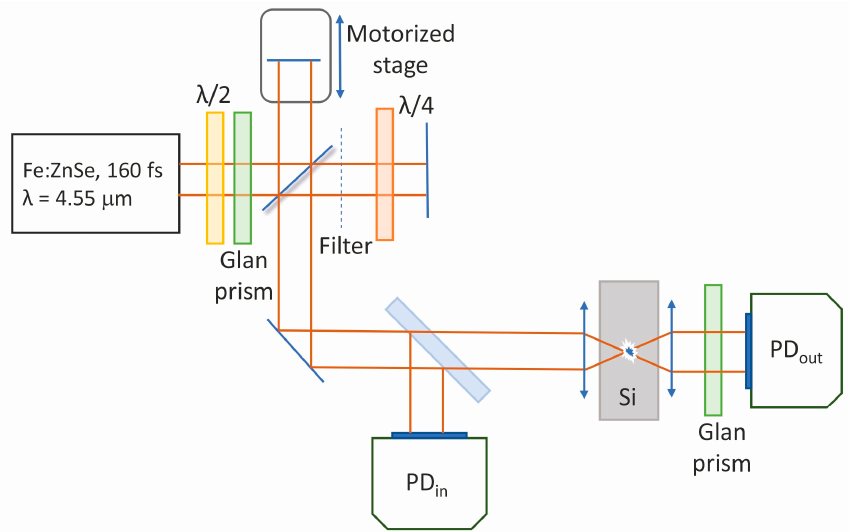
Figure 1. Experimental setup. The energy of the laser pulse is controlled by a half-wave plate and a Glan prism. The initial laser pulse is split into pump and probe pulses using a Michelson interferometer. The polarization of the pump pulse is orthogonal to the probe pulse. The energy of the laser pulse transmitted through the sample is controlled by a photodetector.